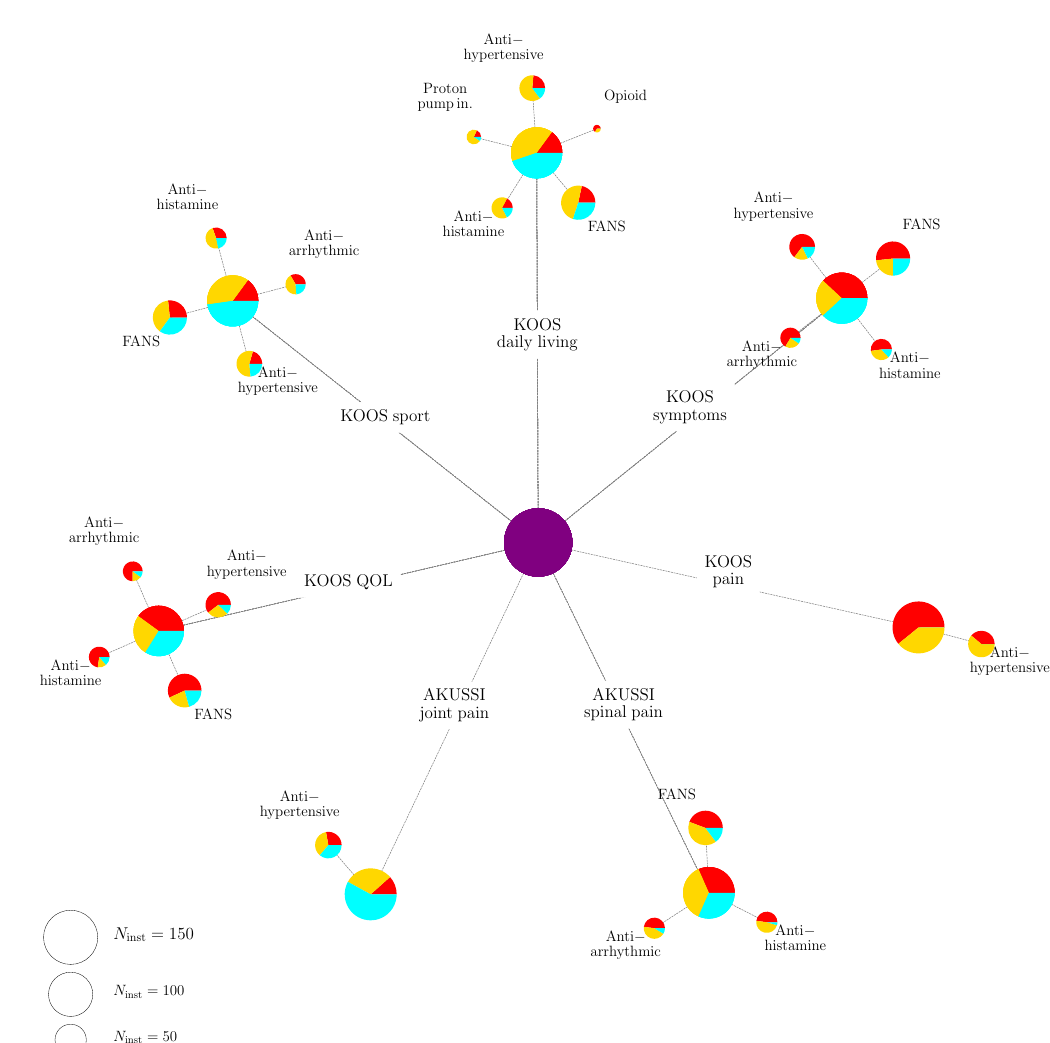
Figure 2. Dense results of the Fisher’s exact test. For each QoL score, a first level of pie charts is shown, representing the psycho- physical state of the patients (from red to cyan, corresponding to progressively better health conditions); the area of each circle is proportional to the number of patients for which the information about that QoL score is available. A second level of pie charts, then, shows the impact of drugs on that particular QoL score, with the same conventions as before. As a reference, we also show three benchmark circles whose sizes correspond to the case where the number of patients is 150, 100 and 50, respectively. In Figure 2, for each QoL score a first pie chart is represented, whose dimension is proportional to the number of patients for which there is information for that given QoL score. The colours are divided according to the psycho-physical state of the patient: from red (bad health conditions) to cyan (absence of pain). In the second level of pie charts, only the drugs for which evidence of correlation has been found are shown. The area of the circle is proportional to the number of patients taking that drug for that given QoL score. As a reference, we also show the size of the circles corresponding to three benchmark values for the number of patients, i.e., 150, 100 and